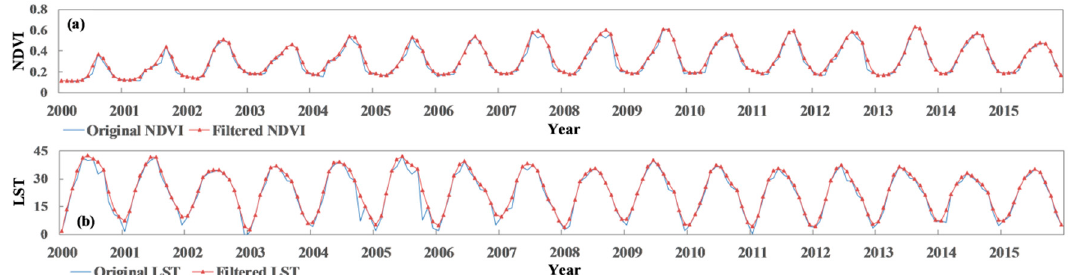
Figure 3. Original and filtered Normalized Difference Vegetation Index (NDVI) ( a ) and land surface temperature (LST) ( b ) time series.